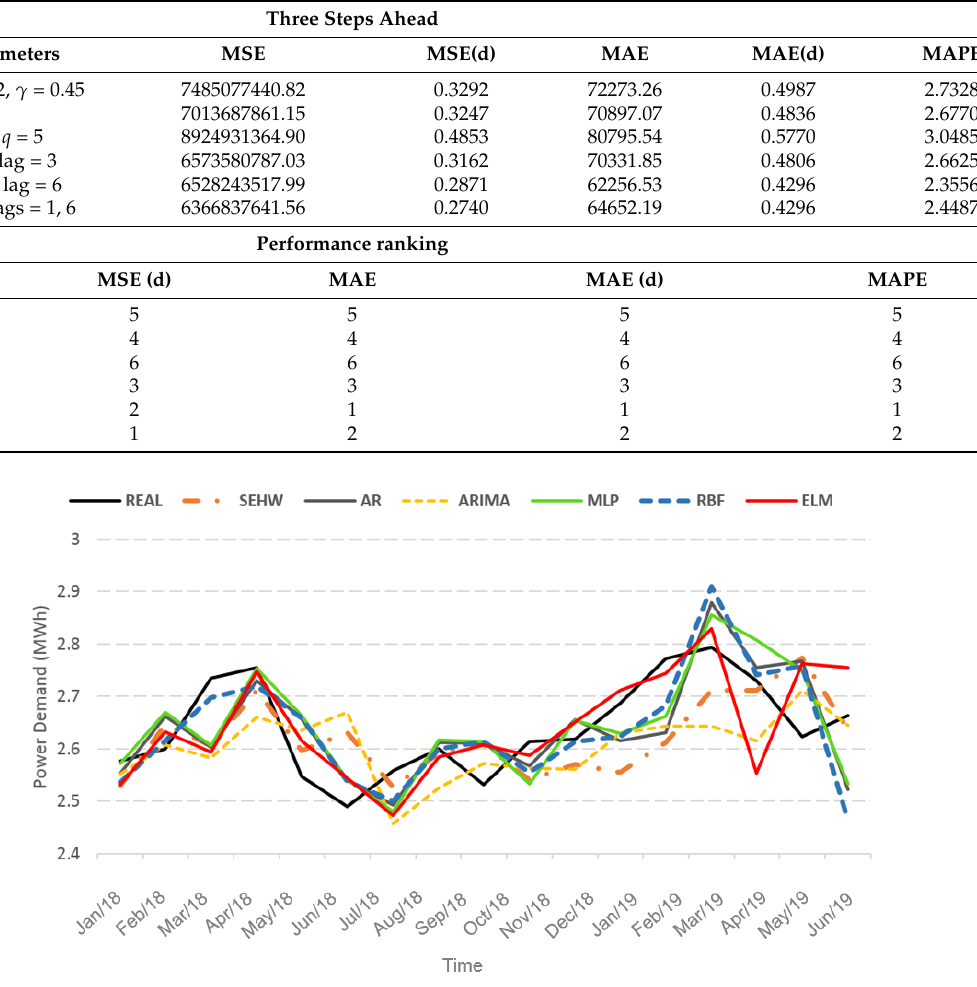
Figure 5. Graph comparing actual data with data predicted for three steps ahead, using HW, AR, ARIMA, MLP, RBF, and ELM models.